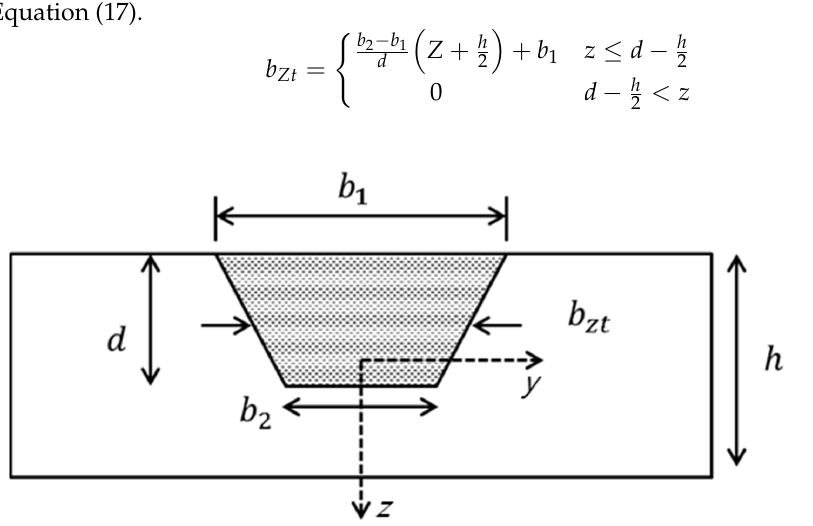
Figure 5. Trapezoid shape heat affected zone (HAZ).